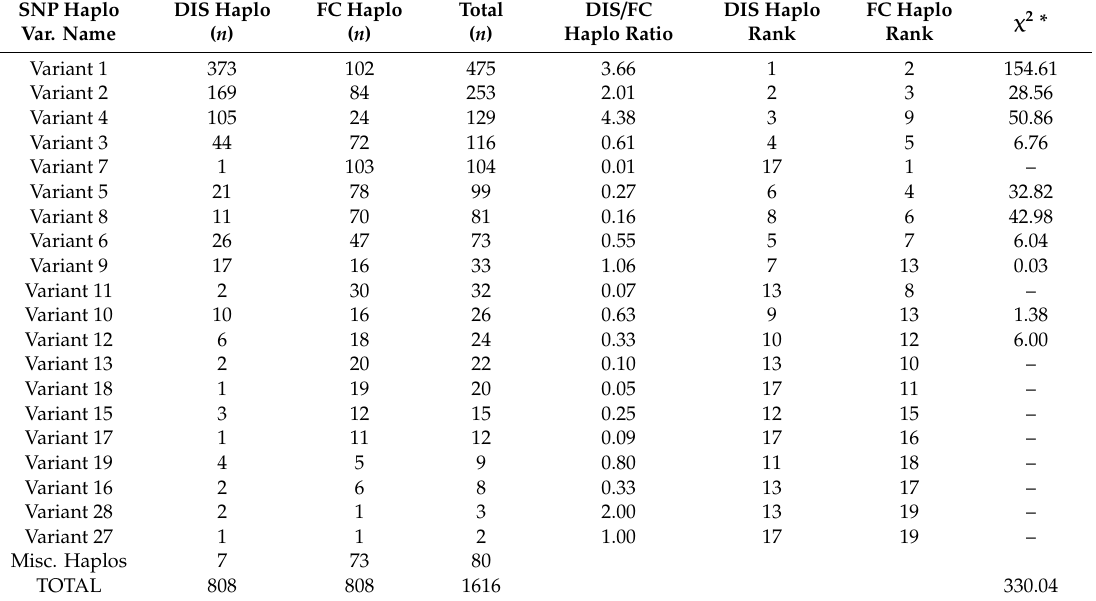
Table 7. Analysis of equalized DIS and FC SNP haplotypes each ≥ 5 in frequency among overlapping families in both T1DGC studies 1